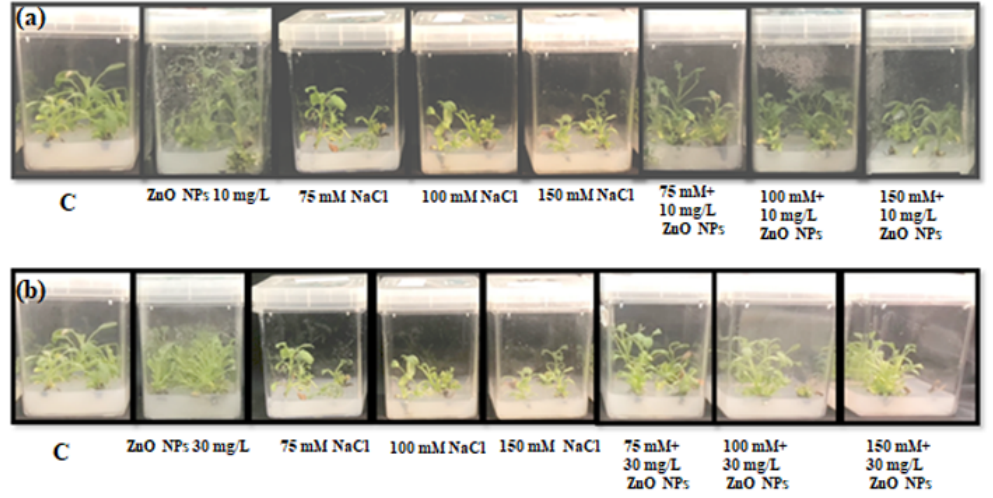
Figure 4. Effect of 10 mg/L ( a ) and 30 mg/L ( b ) of zinc oxide nanoparticles on in vitro regeneration of Salvia officinalis subjected to 0, 75, 100, and 150 mM NaCl.